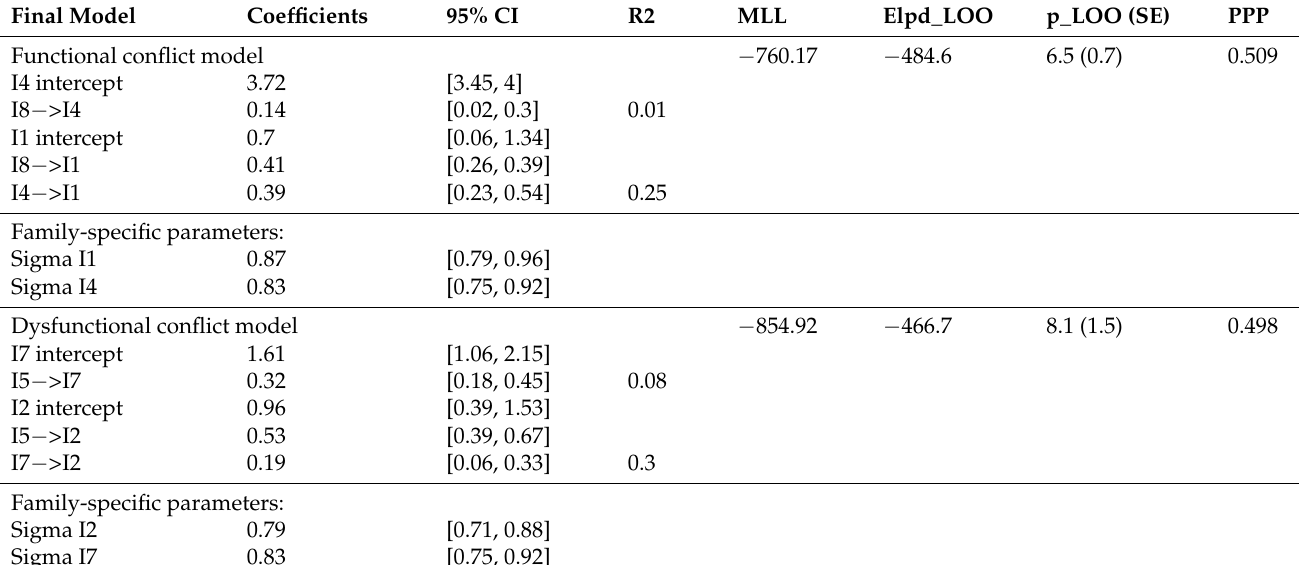
Table 5. Summary of